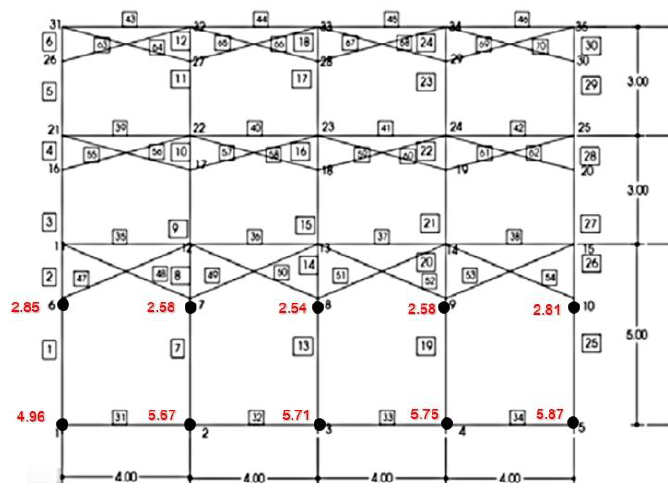
Figure 13. Damage index of the original building structure.